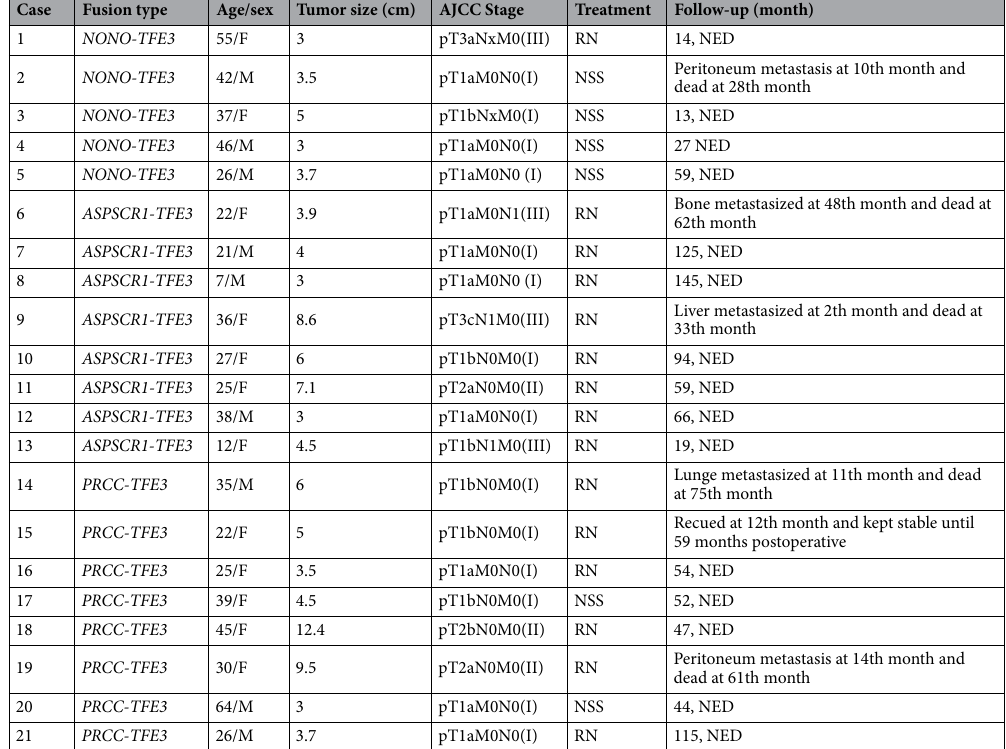
Table 1. Clinical data of the Xp11.2 translocation renal cell carcinoma. F female, M male, NED no evidence of disease, NSS nephron-sparing surgery, RN radical